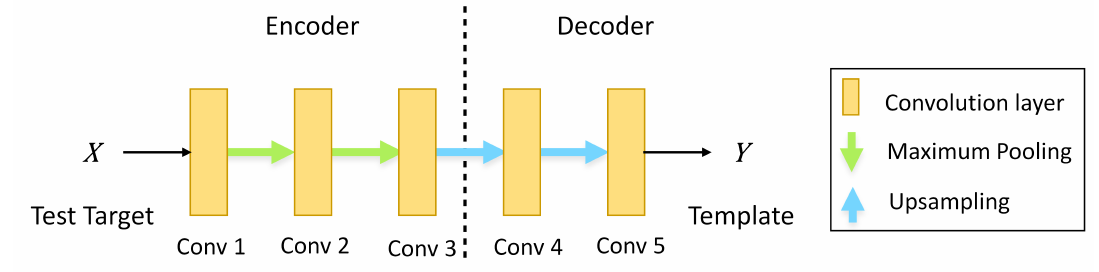
Figure 4. An example of the AE for the proposed algorithm. The AE in this example contains 5 convolution layers, which are denoted by Conv i , i = 1,...,5.